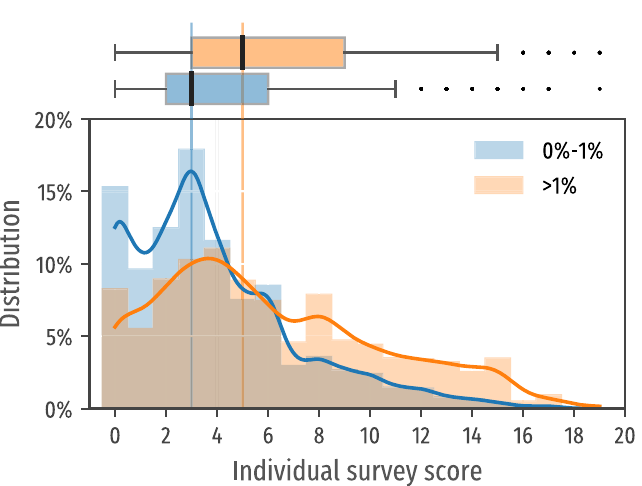
Figure 3. Distribution of individual risk for the population located in low risk zones (blue) where the predicted incidence rate is lower than 1% and for the population in high risk zones (orange). Note that the proportion of lower scores ( < 4 ) is higher in the lower risk communities (bottom). Score medians in both subpopulations (3 and 5 respectively) with quartiles are reported in the upper box